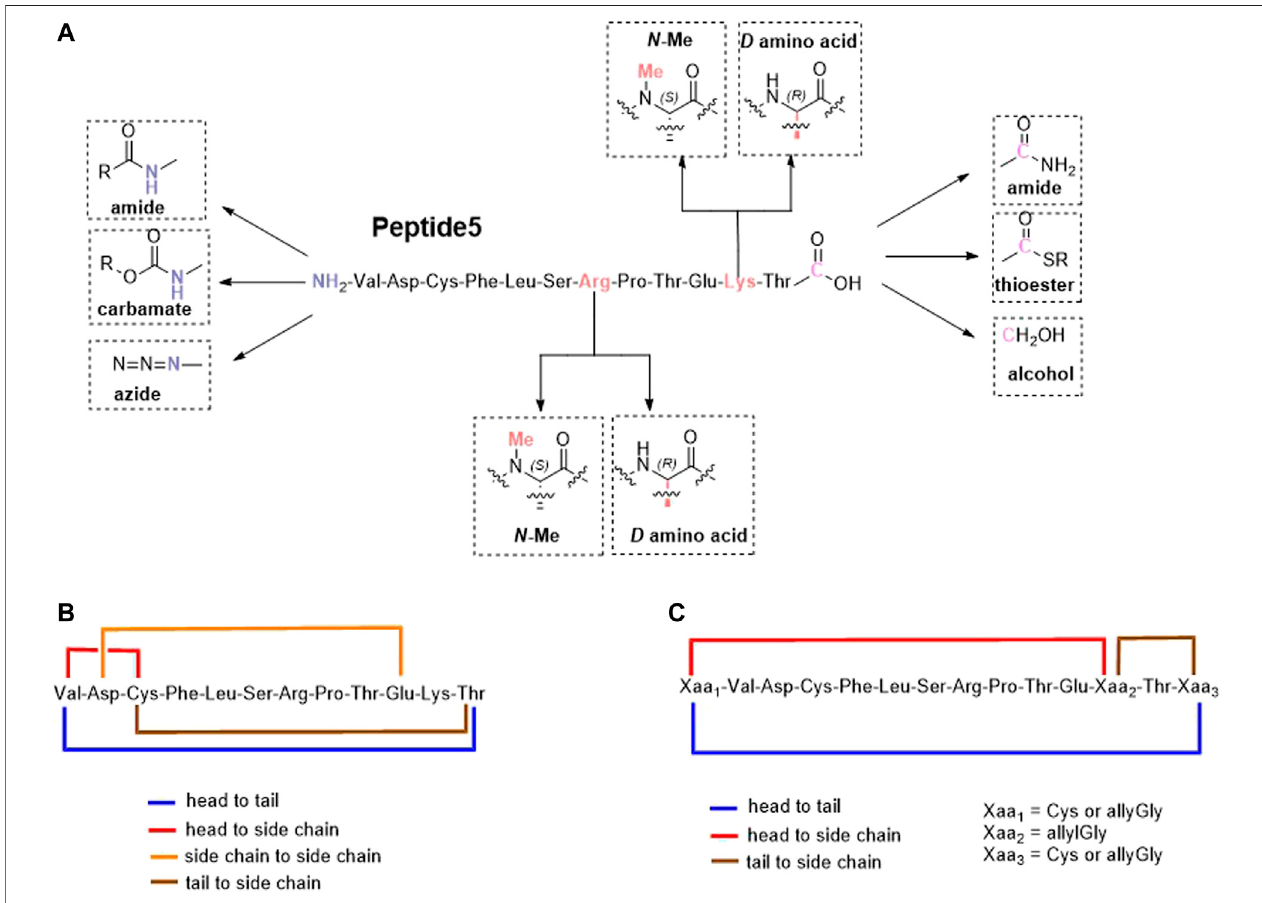
FIGURE 1 | Proposed linear (A) and cyclic variants using either existing amino acids (B) or introduced handles (C) of the connexin inhibitory peptide, peptide5.